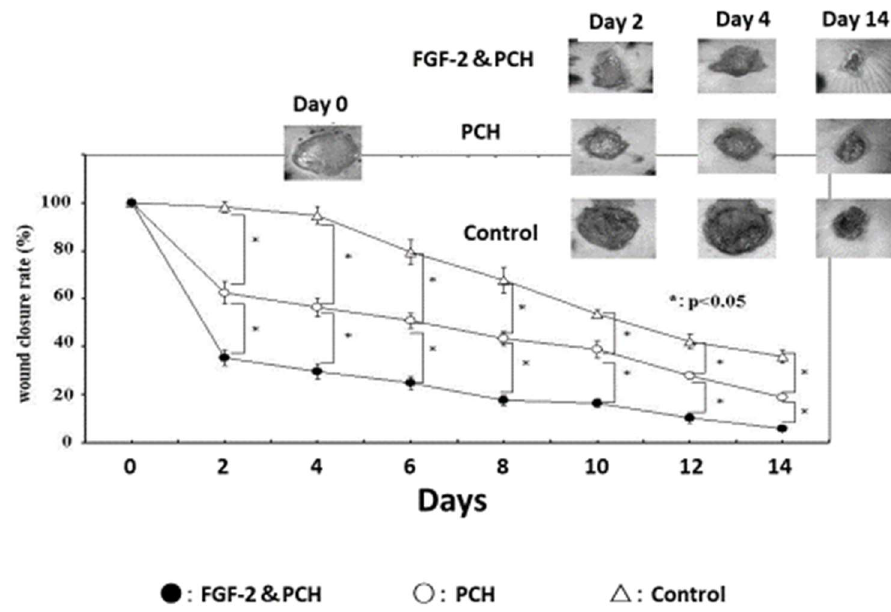
Figure 2. Enhanced wound healing in FGF-2&PCH-treated db/db mice. FGF-2&PCH stimulates wound healing in diabetic db/db mice by the synergistic effects of PCH and FGF-2.